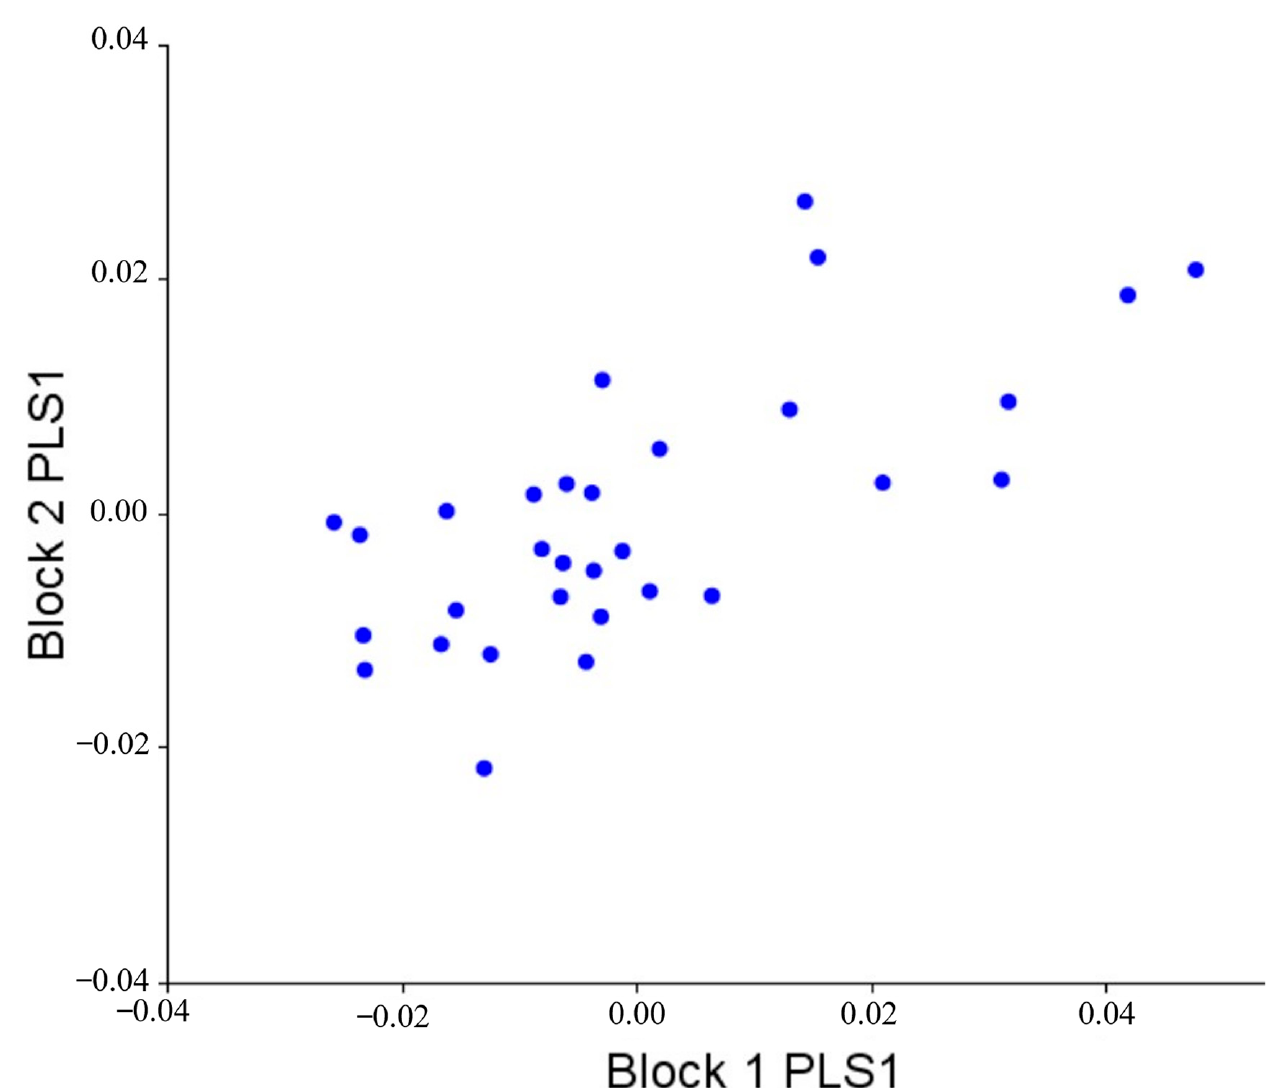
Figure 4. Graph of the PLS1 scores (78.19% of the total variation observed) for the first pair of singular axes of the two modules analyzed: splanchnocranium (Block 1) and neurocranium (Block 2). A low morphological integration between splanchnocranium and neurocranium is observed ( p = 0.404, after 1000 rounds of permutation). Table 2. Single values and paired correlations for the PLS scores between splanchnocranium and